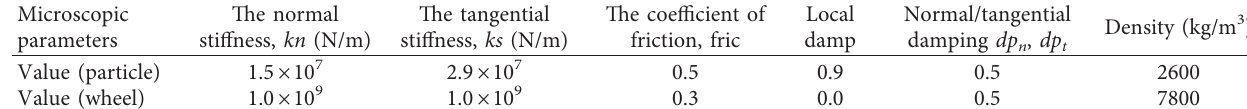
Table 2: Microscale parameters used in the DEM simulations.